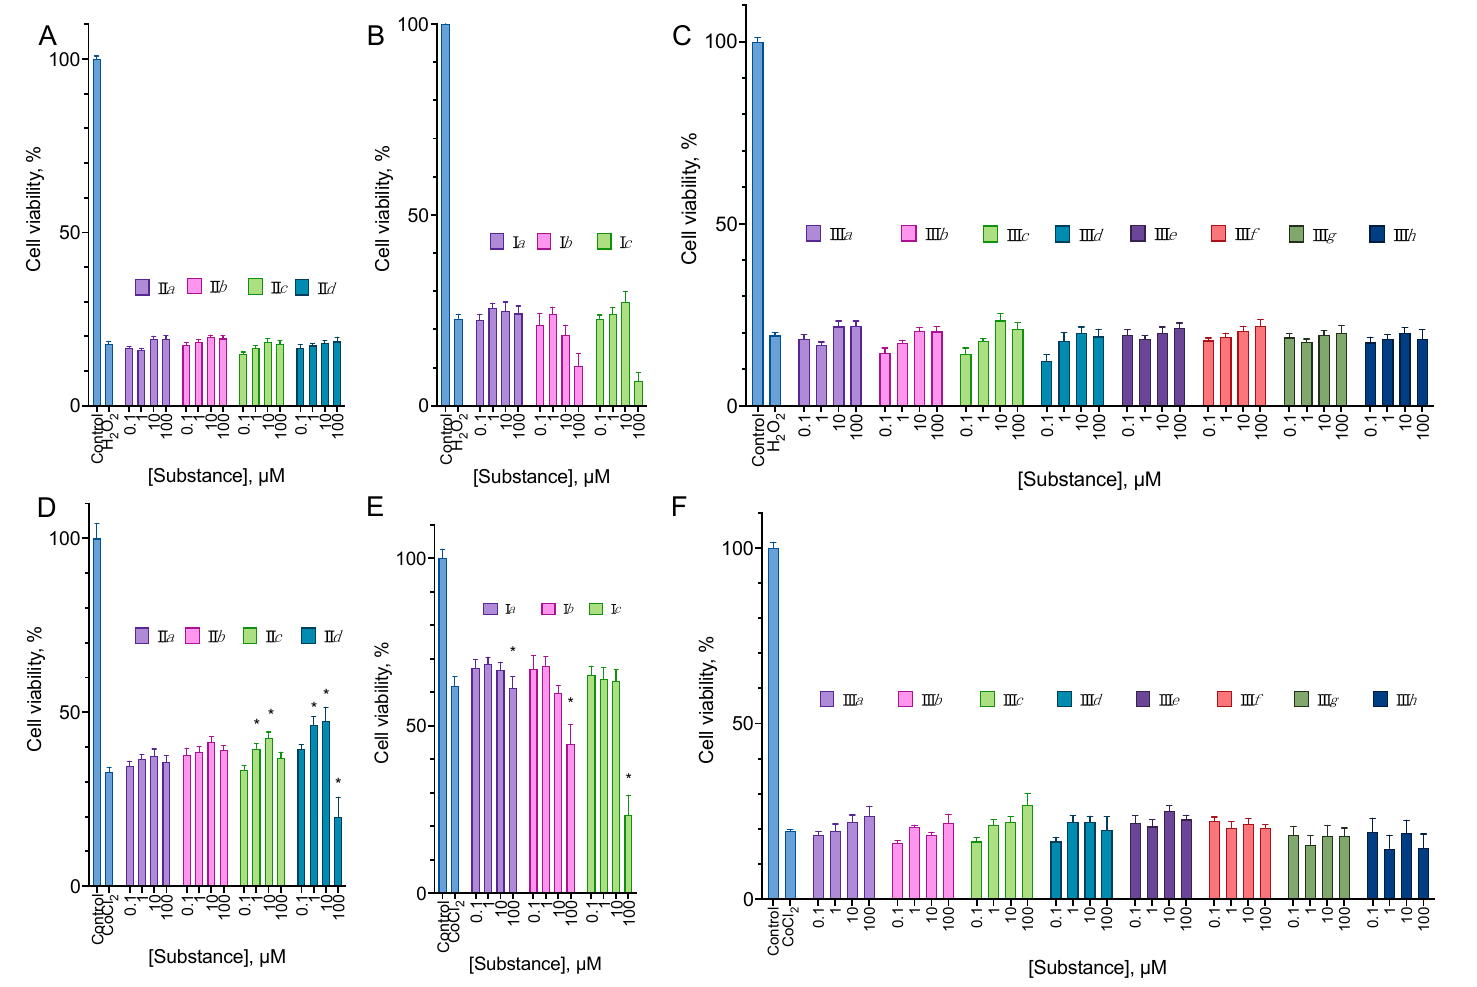
Figure 8. The effect of aryl carbamates II ( A , D ) pyridyl ureas I ( B , E ), and EDU analogs III ( C , F ) on the cytotoxicity of H 2 O 2 ( A – C ) and CoCl 2 ( D – F ) for the SH-SY5Y cell line. 24 h incubation time. MTT assay data, mean ± standard error, n = 3 amalgamated experiments. * Statistically significant difference from the control without substance. ANOVA with the Holm-Sidak post-test, p ≤ 0.05.